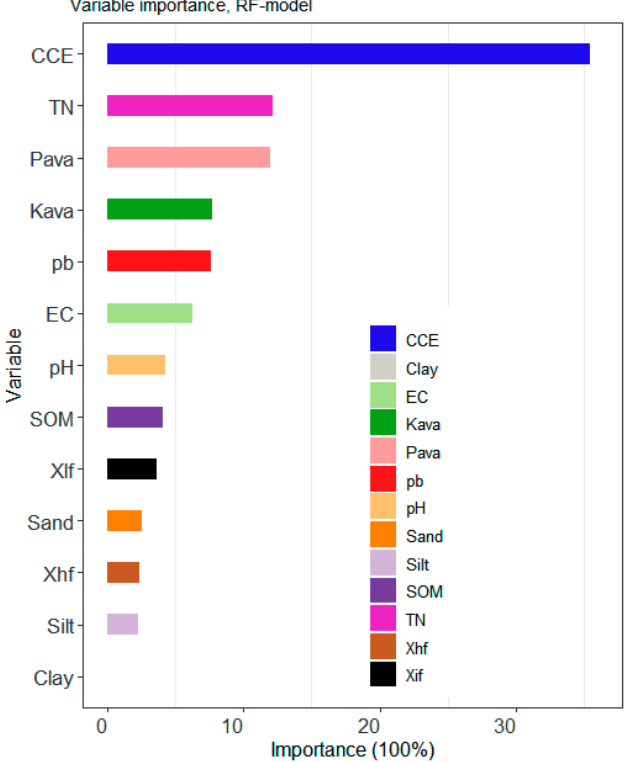
Figure 7. The variable importance analysis of soil properties in the prediction of 137 Cs in- ventory for the random forest model. CCE: calcium carbonate equivalent; TN: total